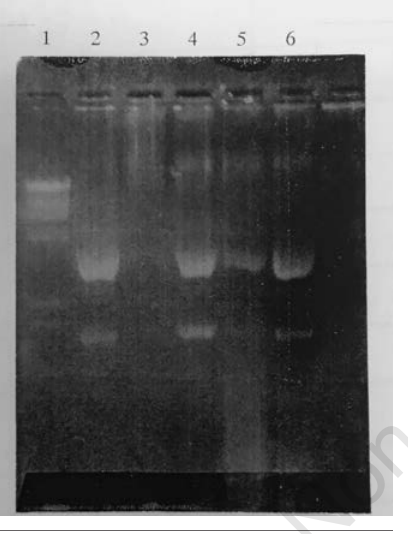
Figure 1. Plasmid DNA from donor (lane 2), recipient (lane 3) and recombinant cells (lanes 4, 5, and 6). Lane 1,